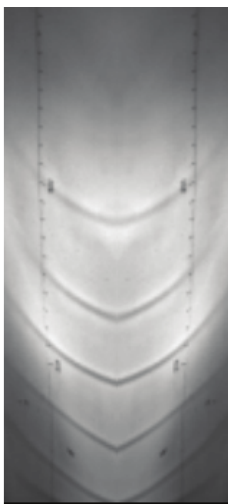
Figure 3: Regular streak-like wave pattern, 𝛽 = 8 ∘ and Re = 22 .